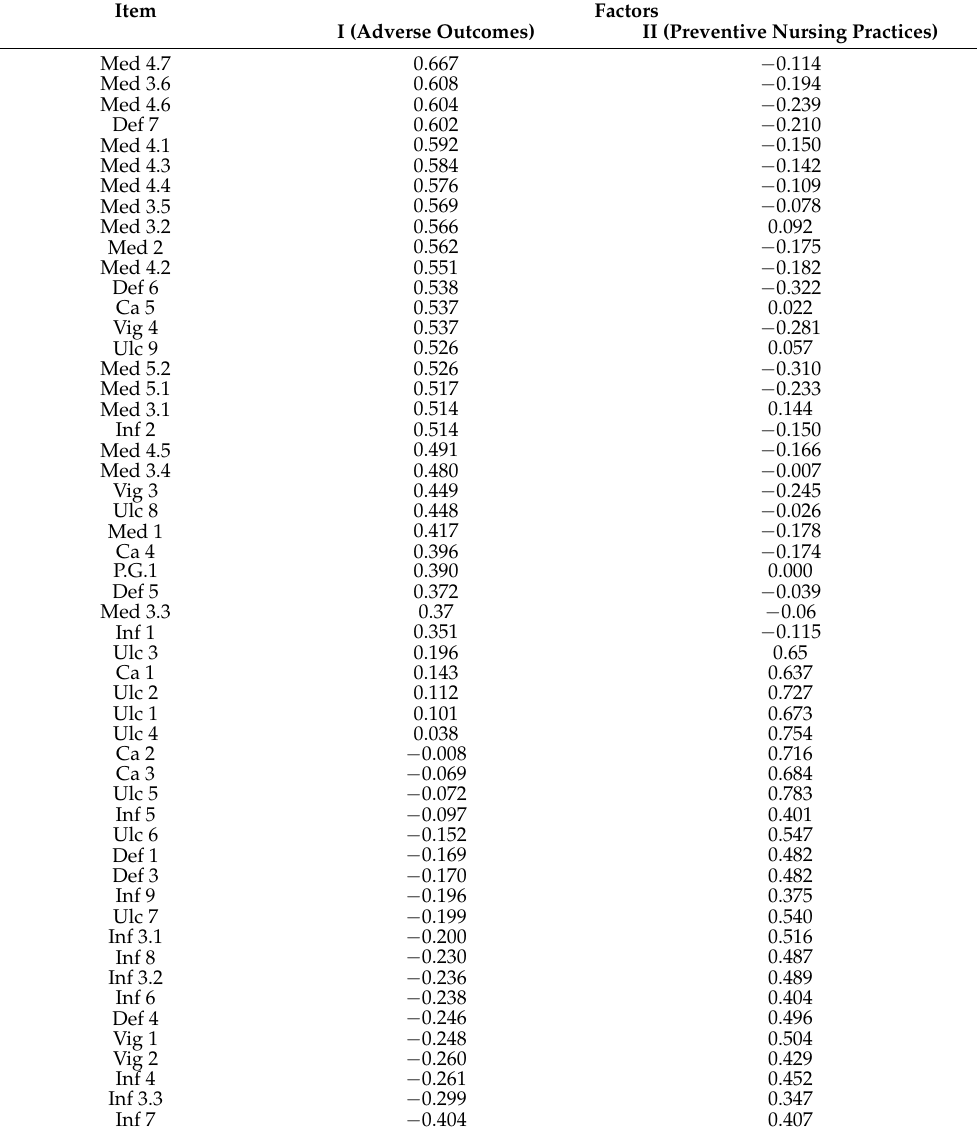
Table 4. Factor load